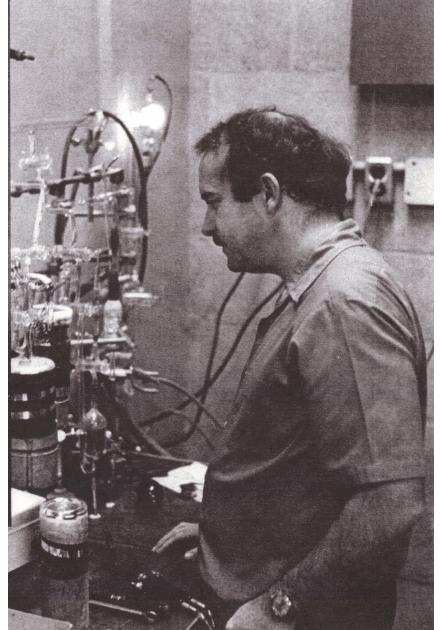
Figure 10. W. Brian Clarke, working on a high vacuum helium extraction apparatus (early